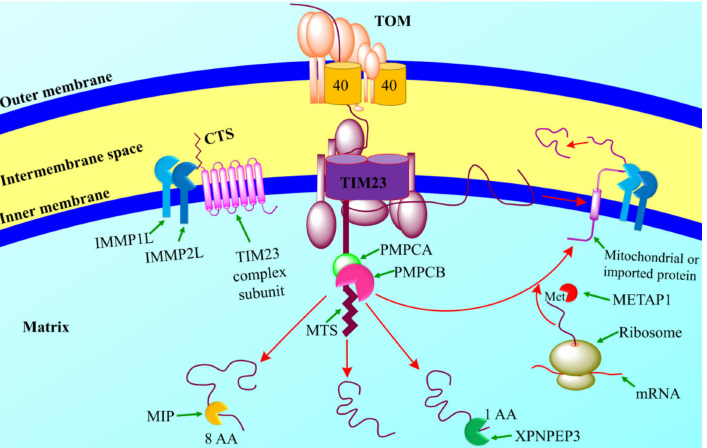
Figure 4. The mechanism of action of mitoprotease peptidases. Mitoproteases are the diverse group of enzymes that transport the biologically active proteins from cytosol to the inner mitochondrion to carry out the correct signals necessary for cellular processes [182]. Mitochondrial processing peptidase (MPP) is the part of the mitochondrial matrix that comprises two subunits such as PMPCA and PMPCB (protease mitochondrial processing peptidase subunit a and b) [183]. Mitochondrial intermediate peptidase (MIP) promotes the cleavage of octapeptide and X-Pro aminopeptidase 3 (XPNPEP3) that removed the amino acids from the amino-terminal of the MPP. Some proteins also pass through further photolytic cleavage via IMMP1L and IMMP2L. IMMPs attack the carboxy- terminal sequence (CTS) to promote cellular assembly [184]. Met aminopeptidase 1D (METAP1D) attacks on amino terminals of the initial Met of some of the polypeptides in order to get functionally active proteins [180]. This figure is reproduced from Quiros et al. [181] after permission from Springer Nature (License No.